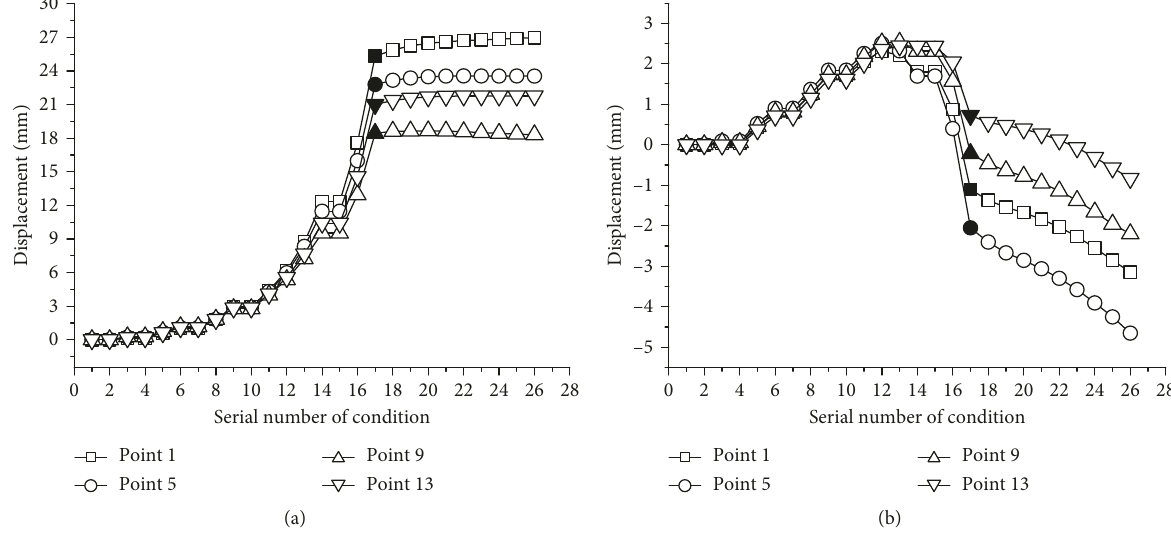
Figure 12: Time history of displacement of the tunnel in Scheme 4. (a) Horizontal displacement. (b) Vertical